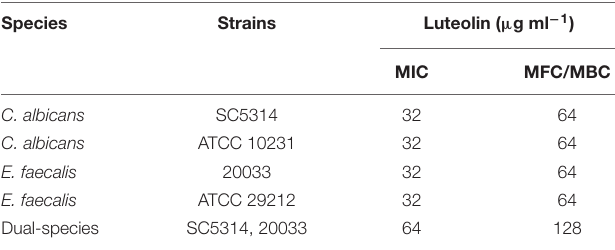
TABLE 1 | Minimum inhibitory non-contradiction (MIC), minimum fungicidal concentration (MFC) and minimum bactericidal concentrations (MBC) of luteolin against C. albicans and E. faecalis